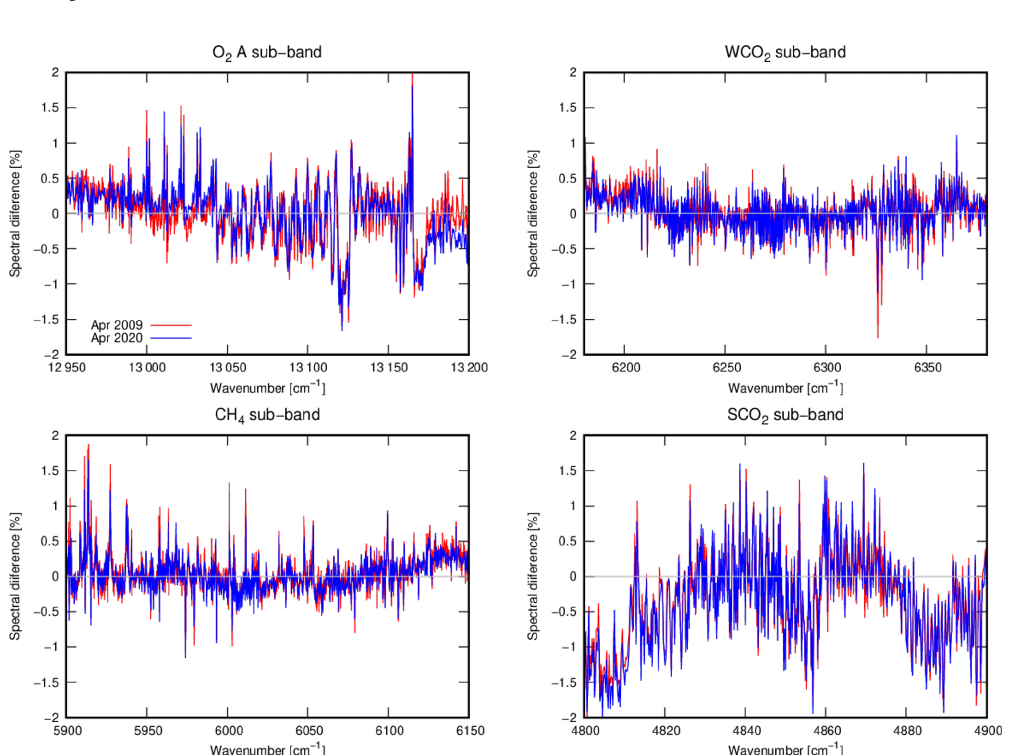
Figure 3. Same as Fig. 1, but for over the ocean.